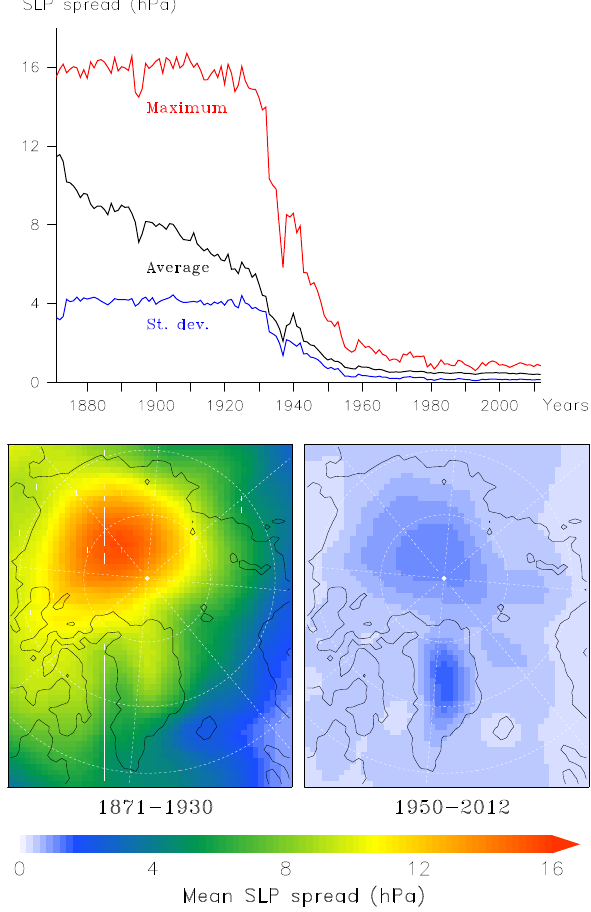
Figure 3. Top: the average SLP spread and its standard deviation are calculated as the seasonal (JJA) average 20CRv2 spread and its standard deviation over the oceanic pixels of our domain. The maximum SLP spread is the value of the oceanic pixel showing the highest seasonal (JJA) average spread of each year. Bottom: the SLP spread is calculated as the average 20CRv2 spread over the 1871– 1930 summers (JJA), left, and over the 1950–2012 summers,